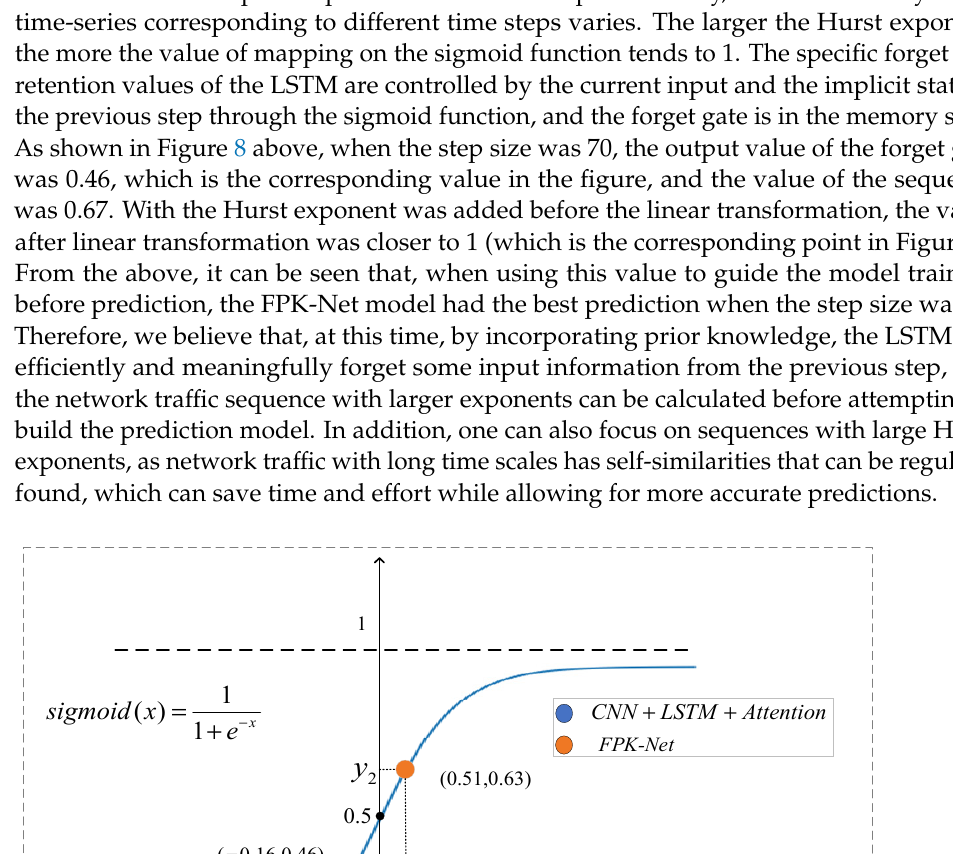
Table 2. FPK-Net model prediction measures under different sliding window lengths.